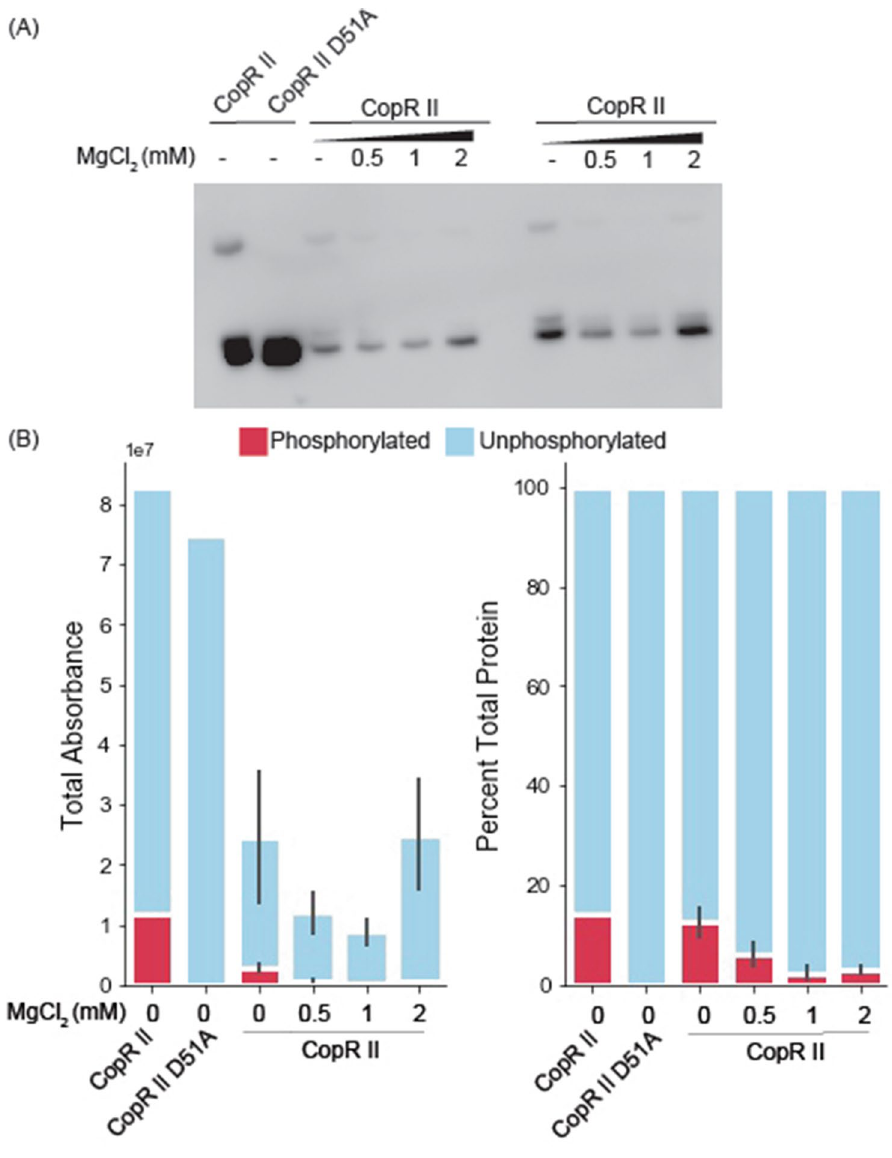
Figure 3. Cultivation with magnesium chloride decreases the phosphorylated population of recombinant CopR II ( A ) phos-tag western blot and ( B ) quantitation by total and percent absorbance for CopR II cultivated in TB media with increased concentrations of MgCl 2 . The first two lanes of CopR II and CopR II D51A were cultivated in a prior batch without MgCl 2 and were stored at cryogenic temperatures for greater than 2 weeks before electrophoretic separation. Bars and error bars represent the averages and standard errors between the average of two technical